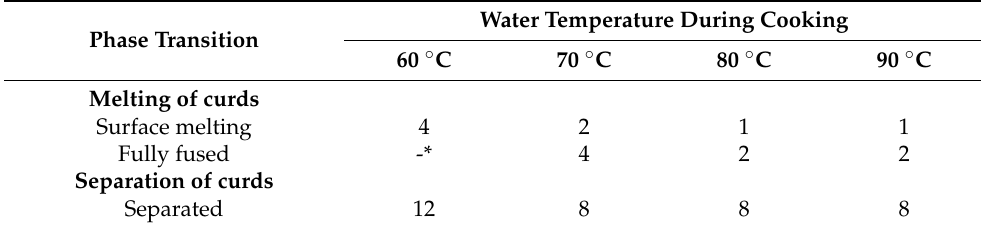
Figure 4. Appearance of curd after cooking at varied conditions. Table 2. Cooking time (min) when curd started melting, fully melted and separated.